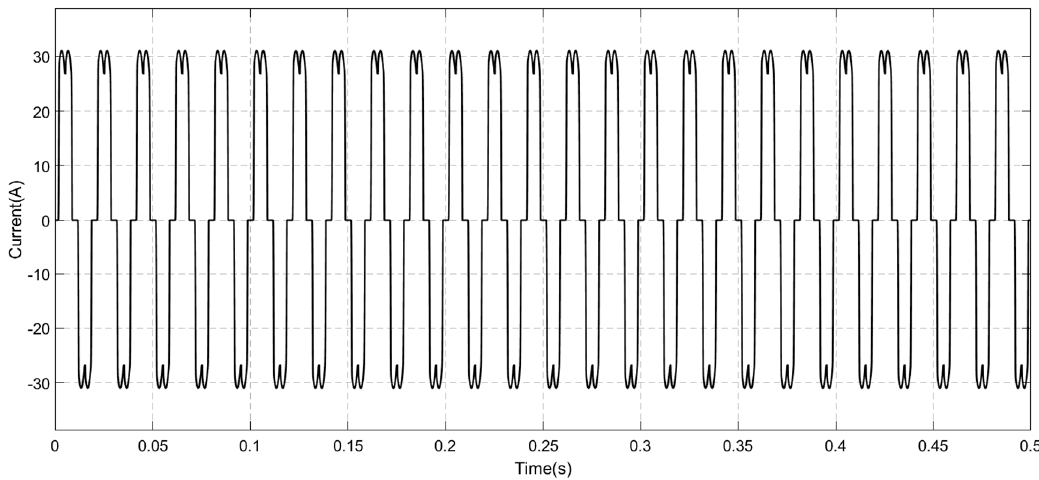
Figure 14. Waveform of load current without PV inverter.